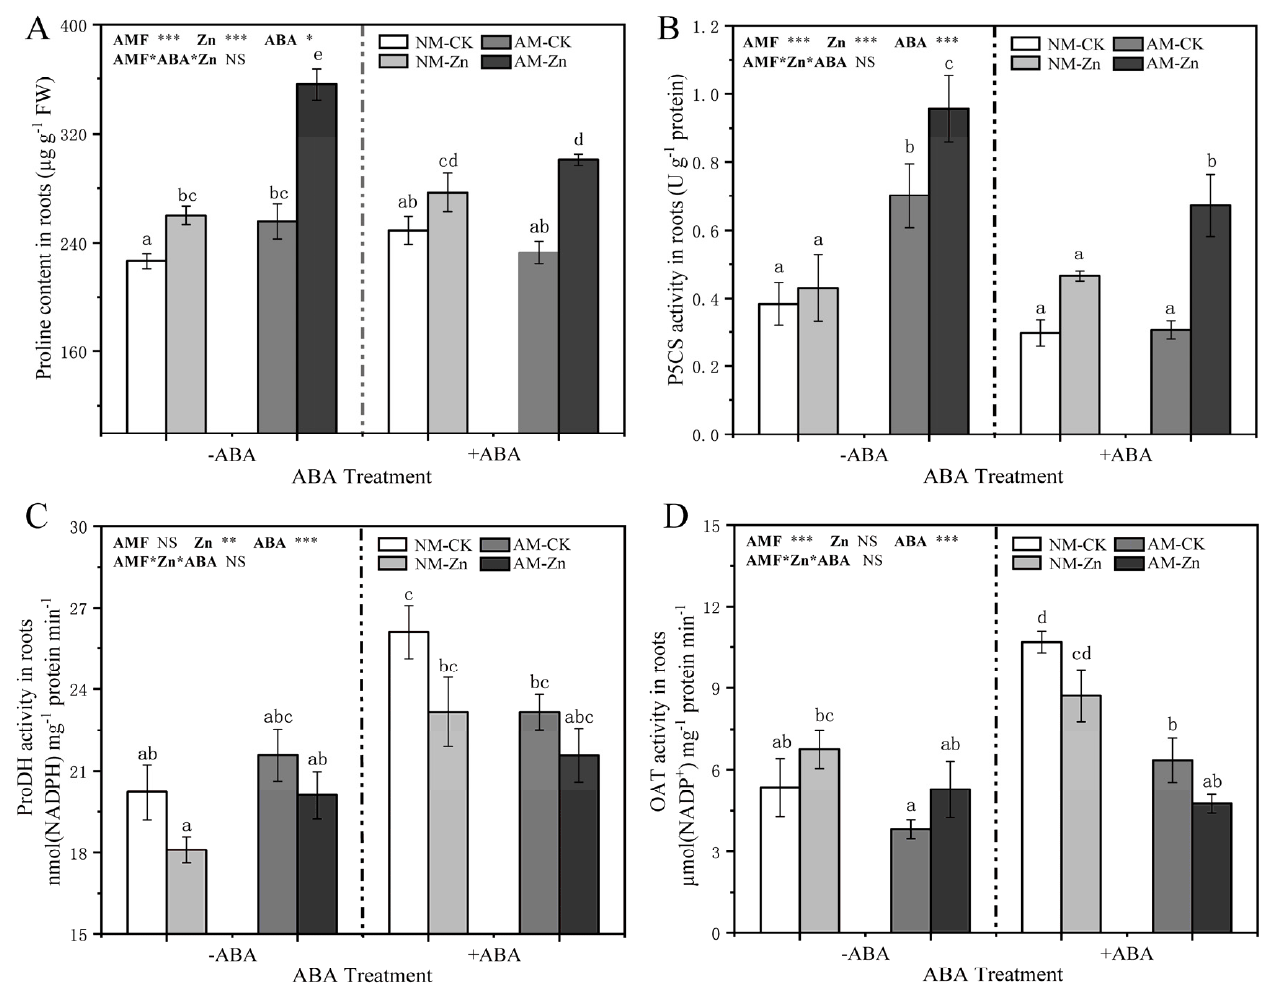
Figure 3. ( A – D ) Proline content, P5CS activity, ProDH activity, and OAT activity in roots. The data show the means ± standard deviations ( n = 3). The different letters above the bars indicate significant differences among the means of the proline content, P5CS activity, ProDH activity, and OAT activity according to Tukey’s test ( p < 0.05). *, p < 0.05; **, p < 0.01; ***, p < 0.001; NS, not significant. The abbreviations used are the same as those used above.